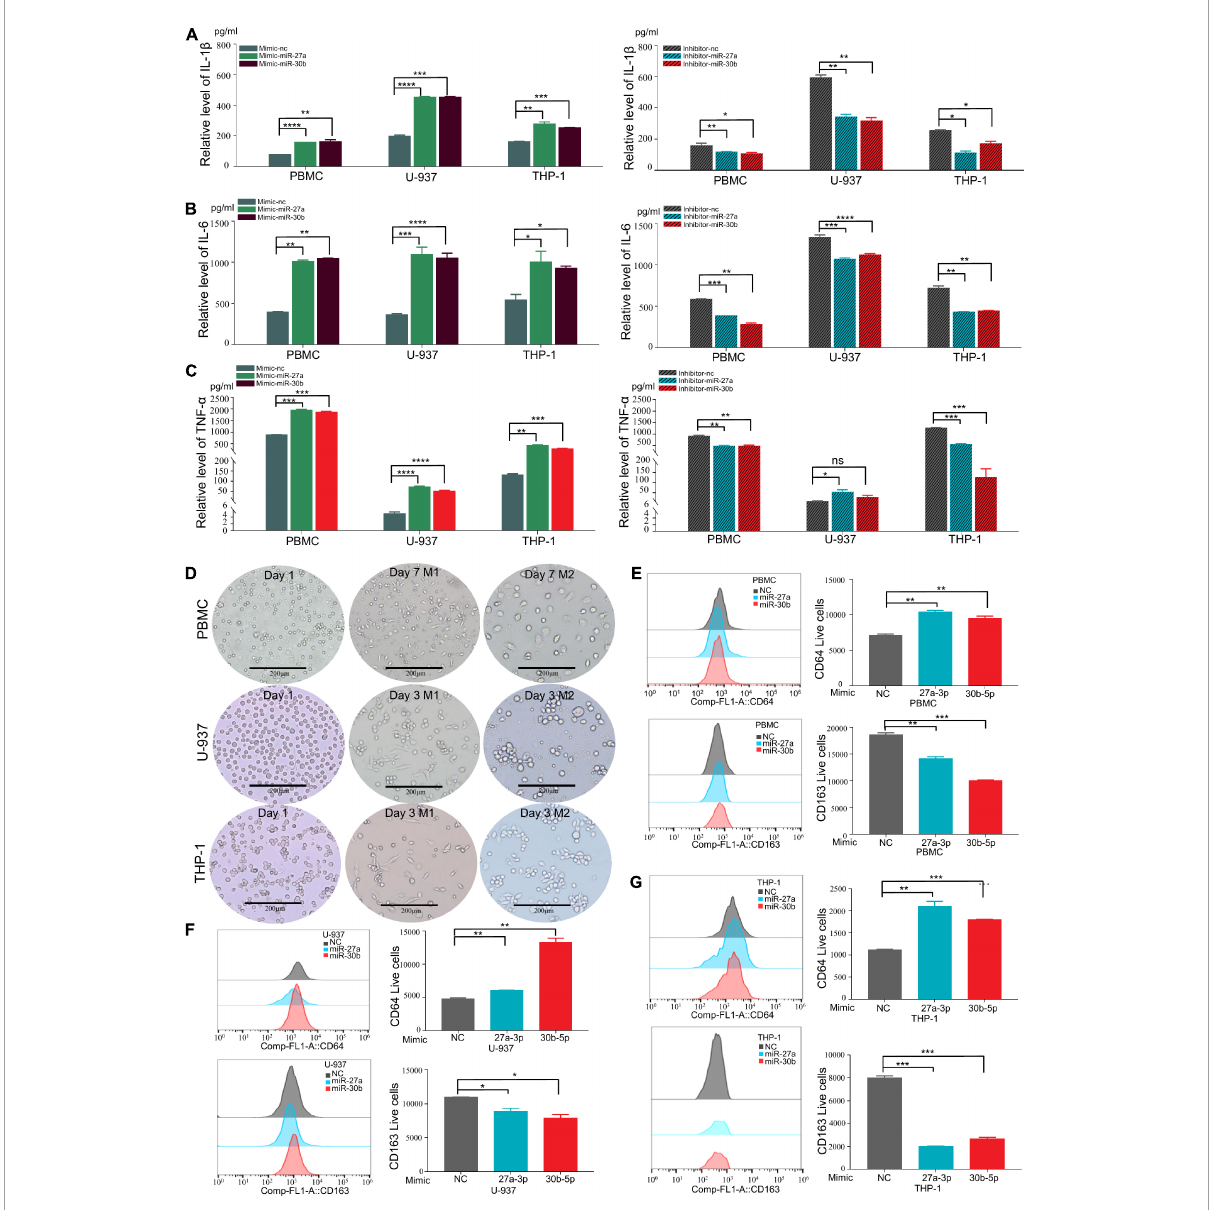
FIGURE3 MiR-27a-3p and miR-30b-5p promote proinflammatory cytokine expression and induce monocytes differentiation into M1 macrophages while inhibiting monocytes differentiation into M2 macrophages. (A) The expression of IL-1 β in monocytes (THP-1, U-937, and PBMCs) when miR-27a-3p and miR-30b-5p were overexpressed or knocked down. Changes in the levels of inflammatory cytokines in culture media were measured by ELISA 48 h later. When miR-27a-3p and miR-30b-5p were overexpressed, IL-1 β cytokine secretion was significantly increased in the treatment group compared with the control group. IL-1 β cytokine secretion was obviously decreased in the treatment group compared with the control group when the miRNAs were knocked down. (B) The expression of IL-6 in monocytes significantly increased when miR-27a-3p and miR-30b-5p were overexpressed. IL-6 cytokine secretion was decreased when the miRNAs were knocked down. (C) The expression of TNF- α in monocytes significantly increased when miR-27a-3p and miR-30b-5p were overexpressed. TNF- α cytokine secretion was decreased when the miRNAs were knocked down. (D) Phorbol 12-myristate 13-acetate (PMA) (100 nM) was added to THP-1 and U-937 culture medium, and human colony-stimulating factor (h-CSF) (20 nM) was added to PBMCs culture medium. THP-1 and U-937 had differentiated into M0 macrophages 24 h later, and PBMCs had differentiated into M0 macrophages 5 days later. Then, lipopolysaccharide (LPS) (100 nM) and interferon-gamma (IFN- γ ) (20 nM) were added to induce differentiation into M1 macrophages, while interleukin-4 (IL-4) (20 nM) and interleukin-13 (IL13) (20 nM) were added to induce differentiation into M2 macrophages. After 48 h, the shapes of cells gradually changed, It showed different types of M1 and M2 macrophages. (E) Compared with the negative control, miR-27a-3p and miR-30b-5p could significantly induce PBMCs differentiation into M1 macrophages (CD64). Conversely, miR-27a-3p and miR-30b-5p significantly inhibited PBMCs differentiation into M2 macrophages (CD163). (F) miR-27a-3p and miR-30b-5p also significantly induced U-937 differentiation into M1 macrophages (CD64) and similarly inhibited U-937 differentiation into M2 macrophages (CD163). (G) The same phenotypes were also validated in THP-1. * P < 0.05, ** P < 0.01, *** P < 0.001, **** P < 0.0001, ns = not